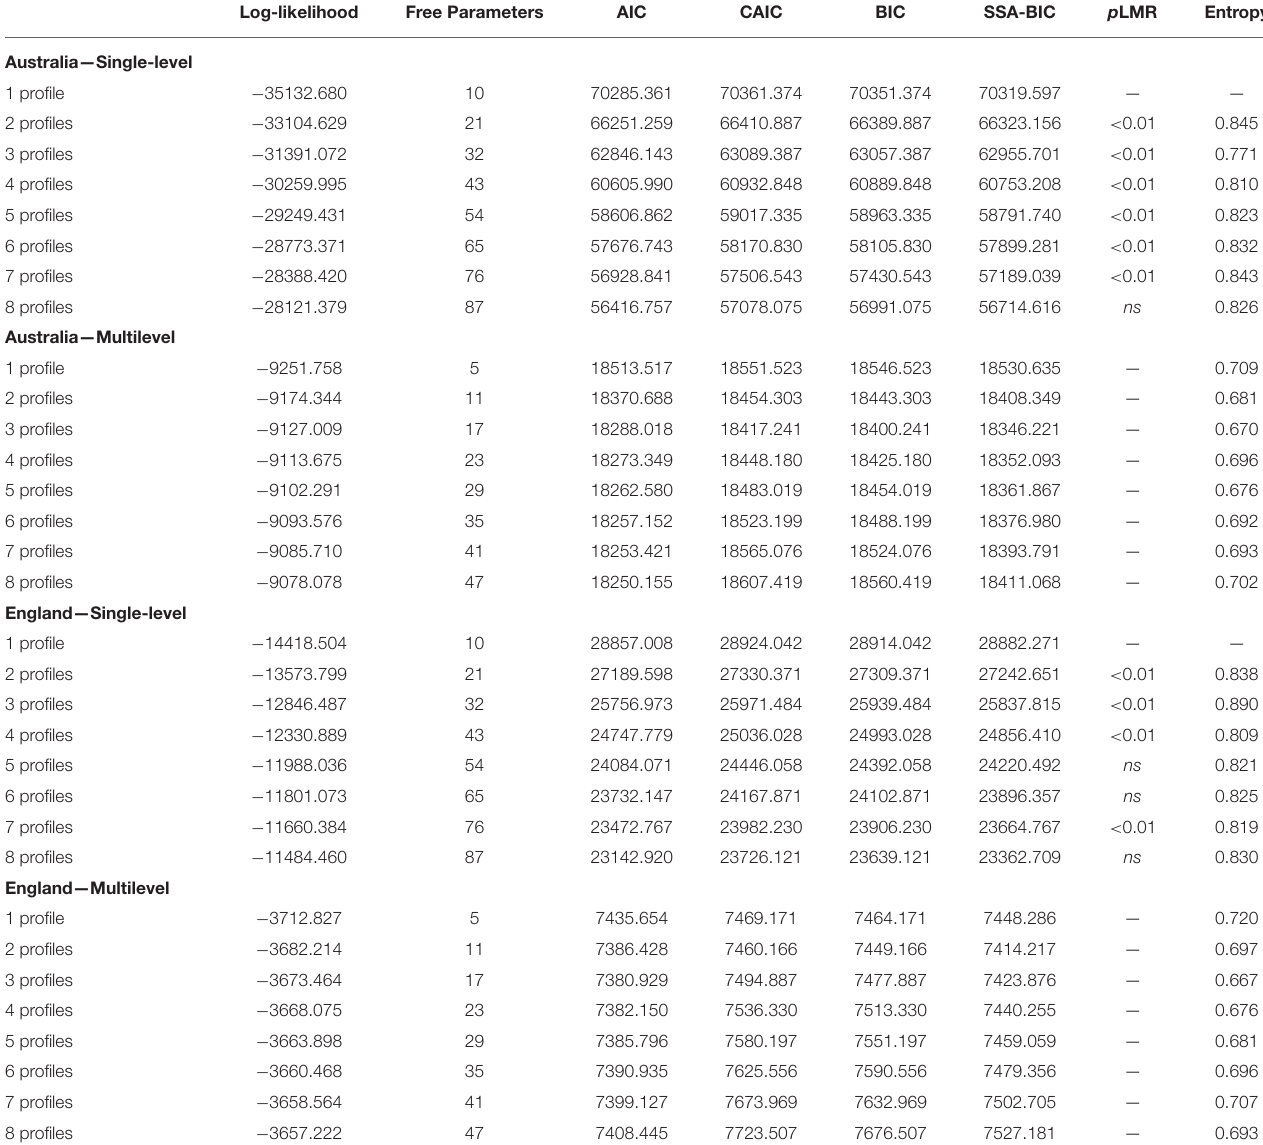
TABLE 2 | Fit statistics and entropy for Australia and